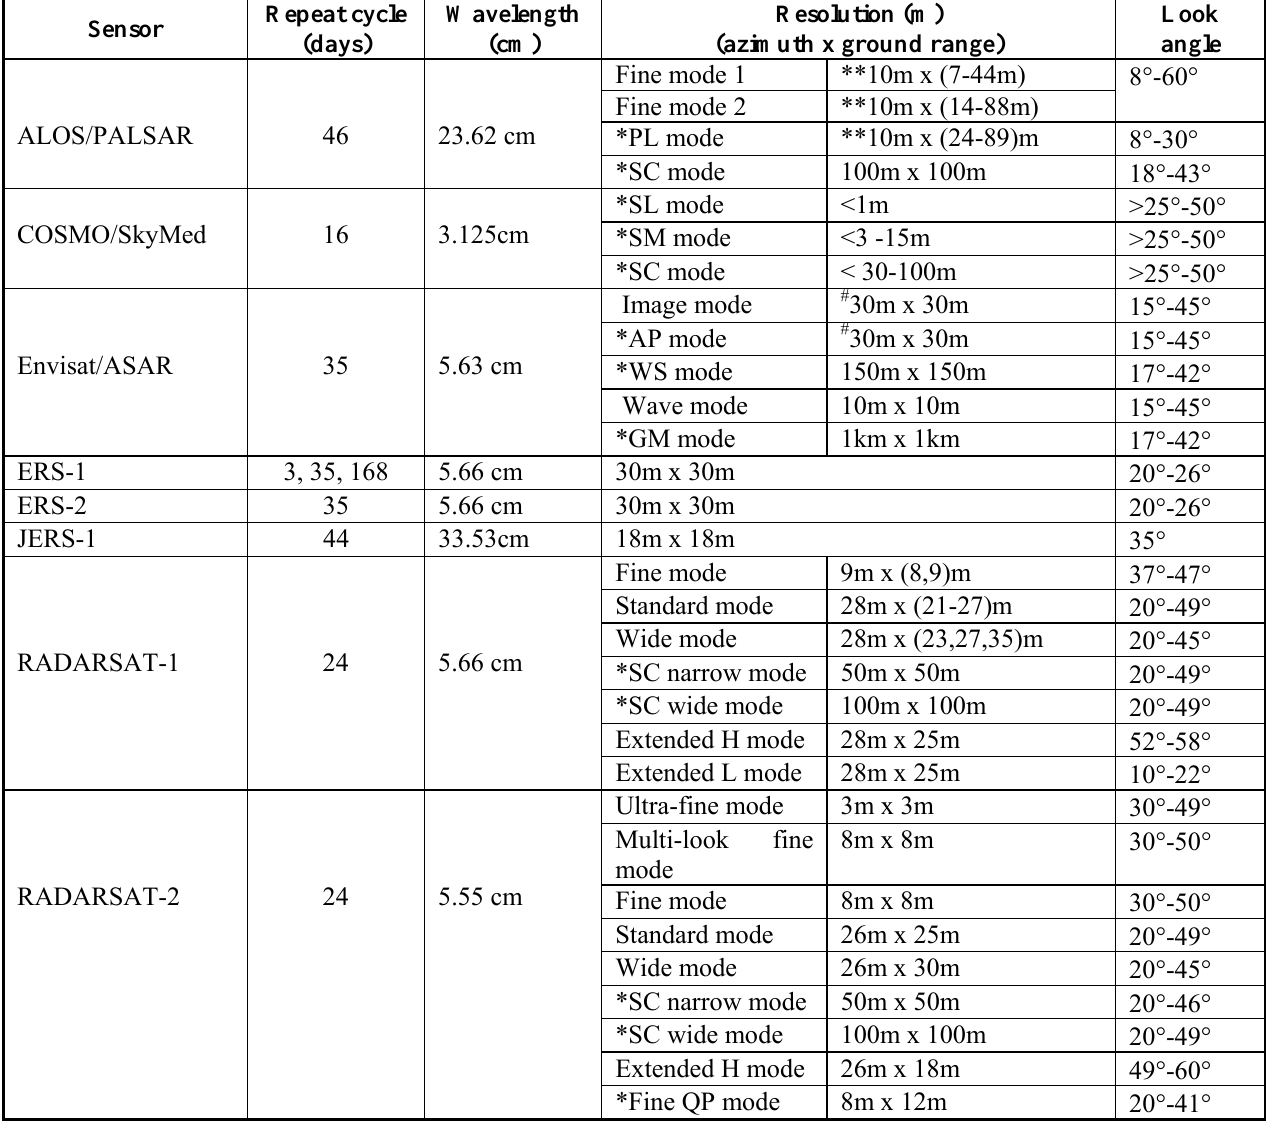
Table 1. InSAR systems and